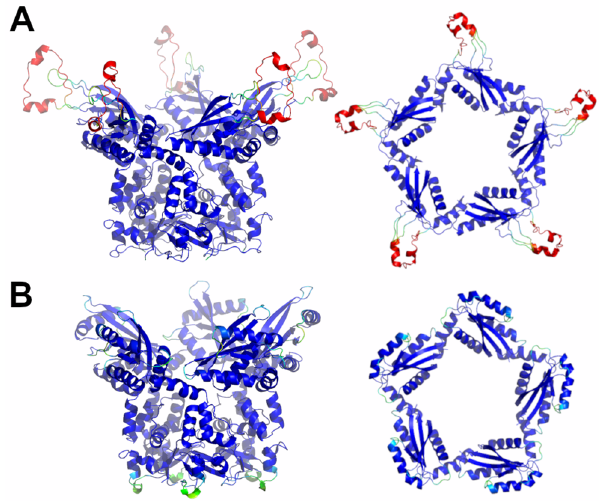
Figure 6. Schematic representation of AF full-length structures of members of sub-Cluster 5B. ( A ) KCTD7; ( B ) KCTD14. For each model, two views (on the left, the full-length pentameric assembly; on the right, the CTD domains only) are shown. Structural models are colored following AF per- residue confidence metric (pLDDT).